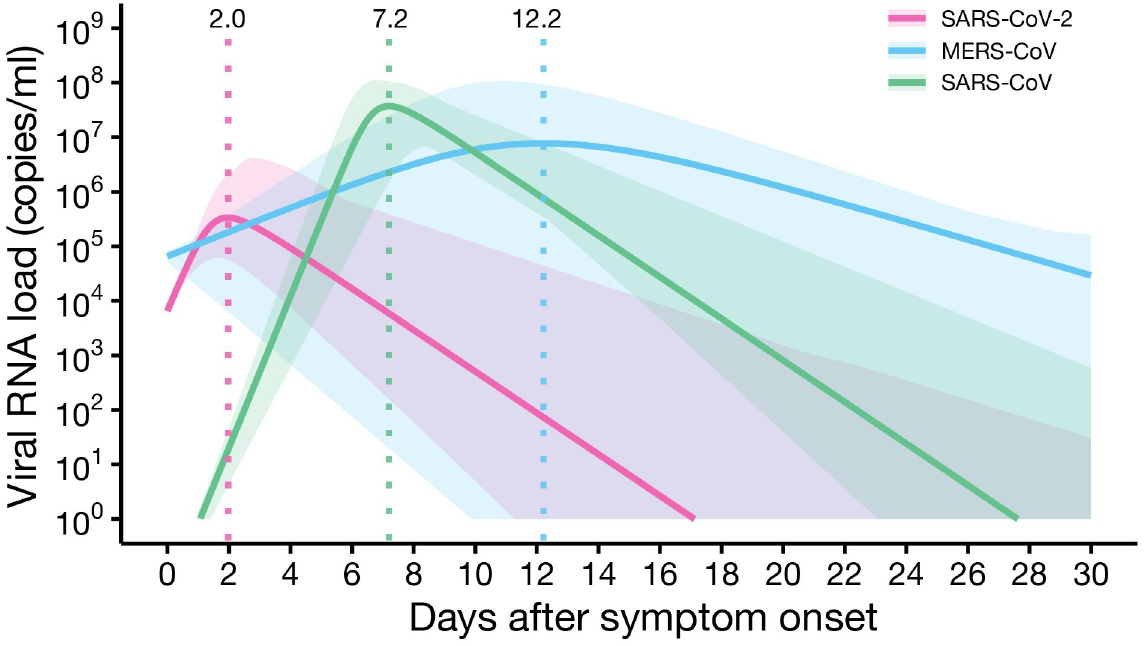
Fig 1. Comparison of SARS-CoV-2, MERS-CoV, and SARS-CoV dynamics. Expected viral load trajectories for SARS-CoV-2, MERS-CoV, and SARS-CoV infection are shown. The solid curves give the solution of Eqs 5 and 6 using estimated parameters (the best-fit population parameters), and the shaded regions correspond to 95% predictive intervals using the estimated parameters for each patient. The data underlying this figure are given in S1 Data.